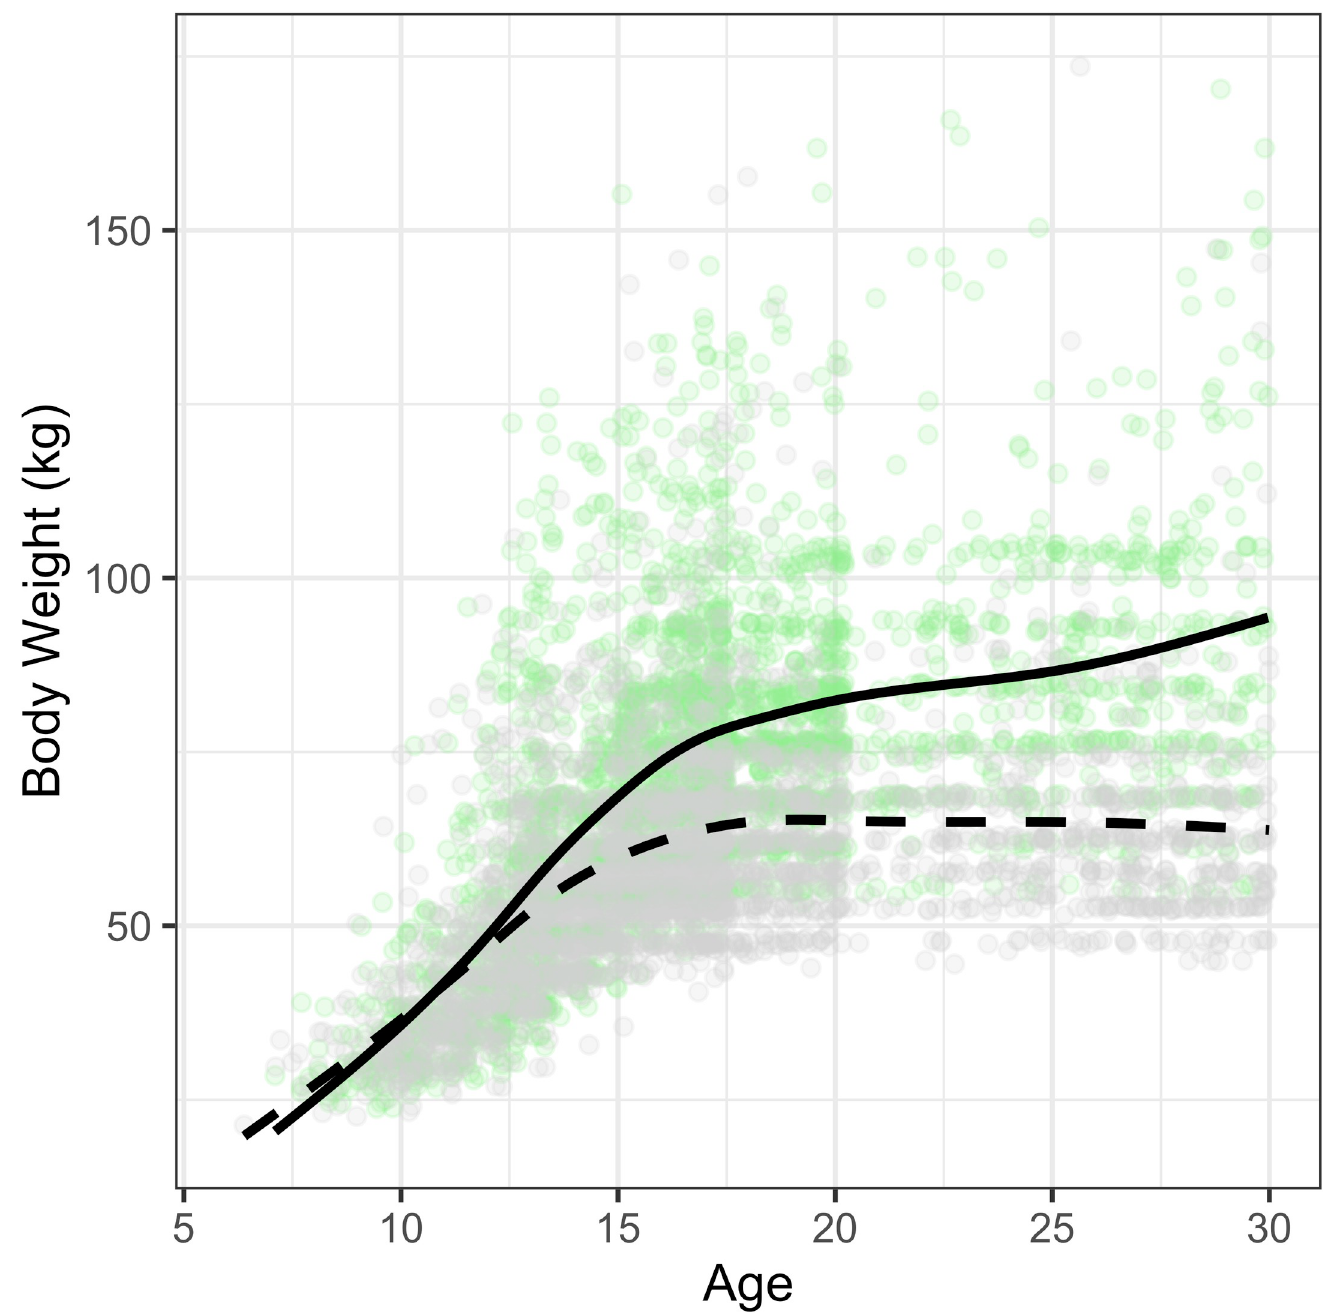
Fig 2. Individual data of age by body weight for males (green) and females (grey) overlaid with locally estimated regression curves.